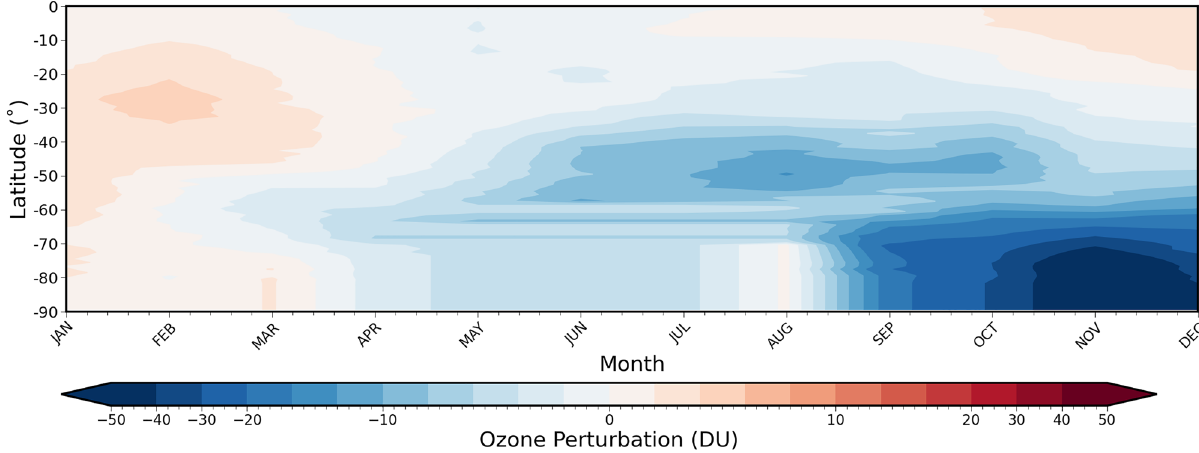
Figure 4. UTLS ozone anomaly (DU) over the southern hemisphere, retrieved by OMPS-LP. The ozone vertical profiles are vertically weighted using the RSS vertical weighting function (see Eq. (1), Stratospheric Temperature Anomaly Data) then integrated over altitudes 13–22